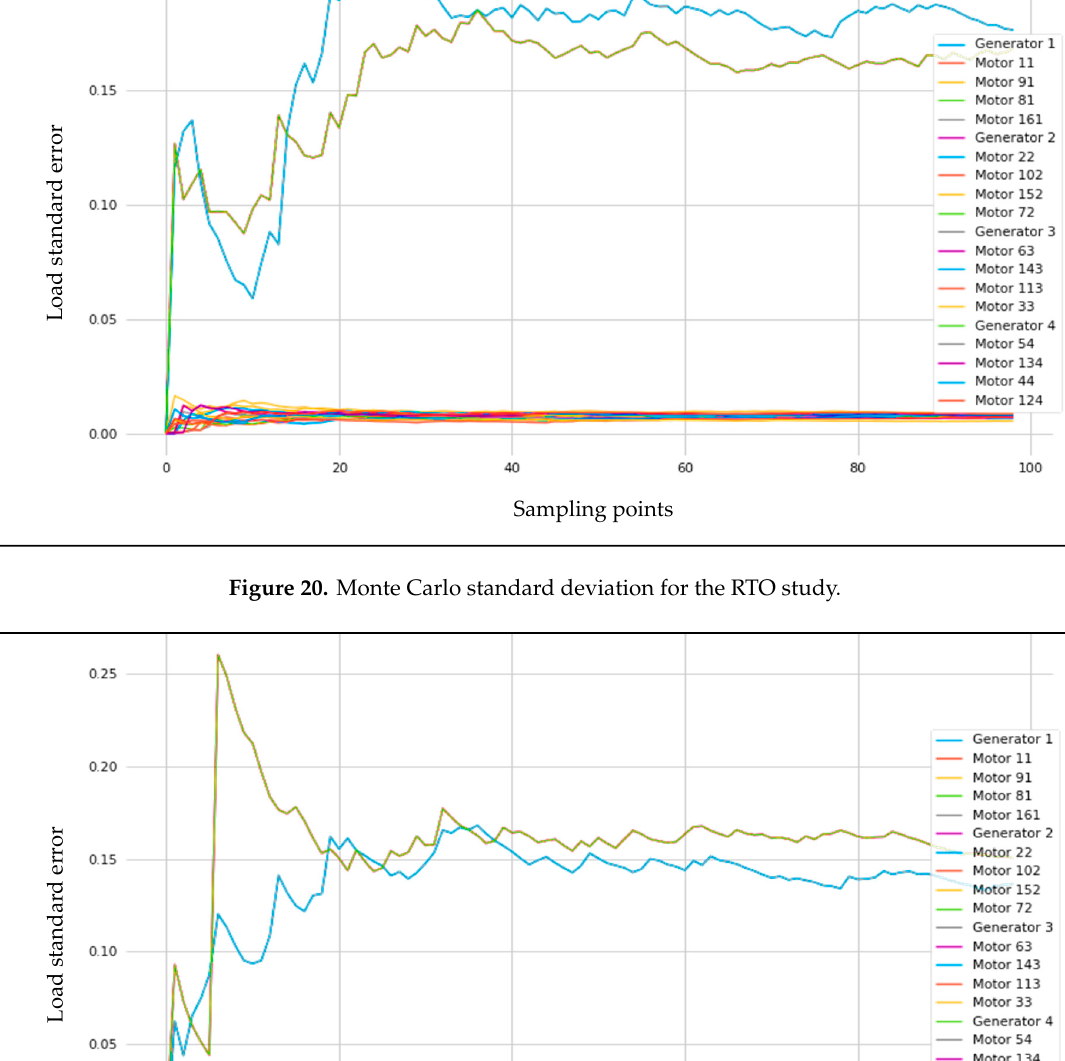
Figure 21. Monte Carlo standard deviation for the TO case Figure 22. Monte Carlo standard deviation for the TO case study.